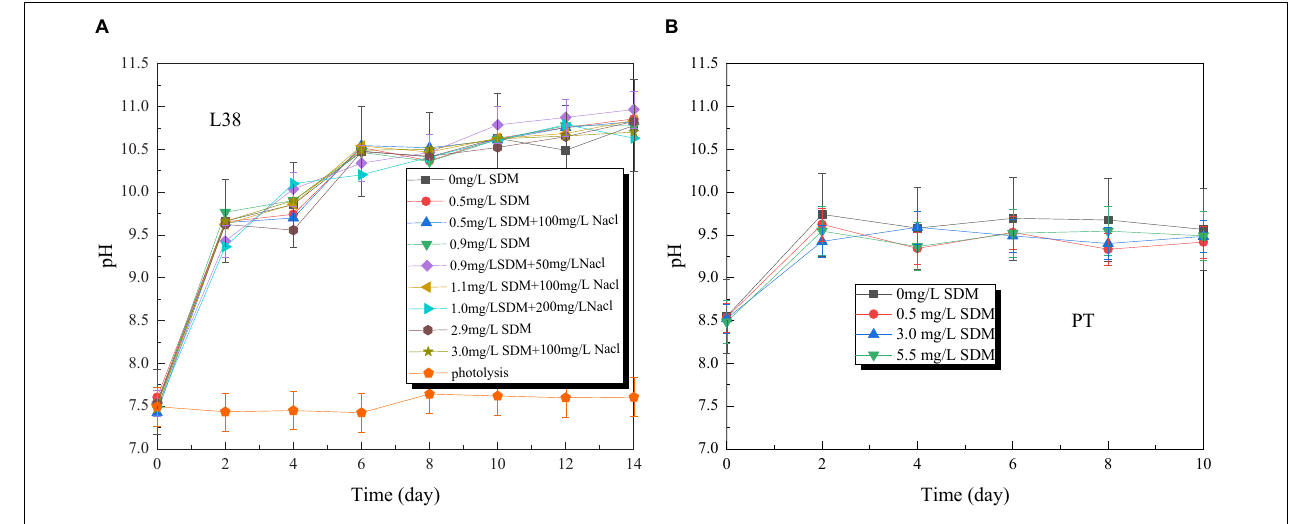
FIGURE 3 | pH variation of Chlorella sp. L38 (A) and Phaeodactylum tricornutum MASCC-0025 (B) under different SDM concentration.